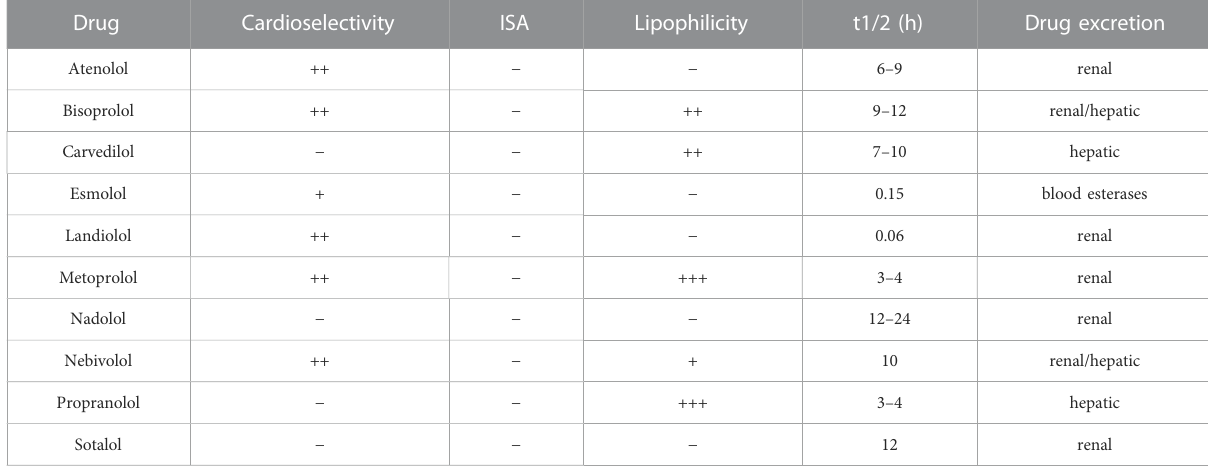
Landiolol Metoprolol